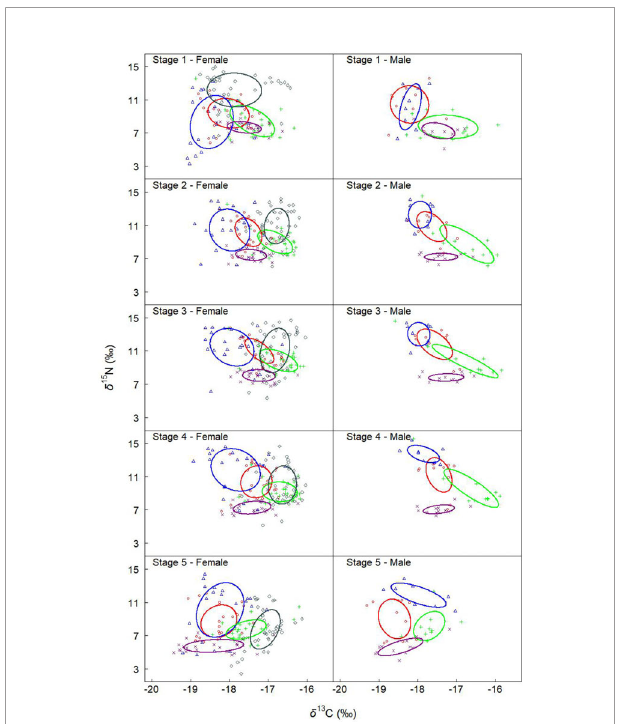
FIGURE 4 | Ontogenetic variation in the isotopic niche of females and males for different groups. Solid lines enclose the standard ellipse areas (SEAc), showing the isotopic niche of D. gigas from different areas and years (red, blue, green, dark slate gray, and dark magenta represent Peru 2013,